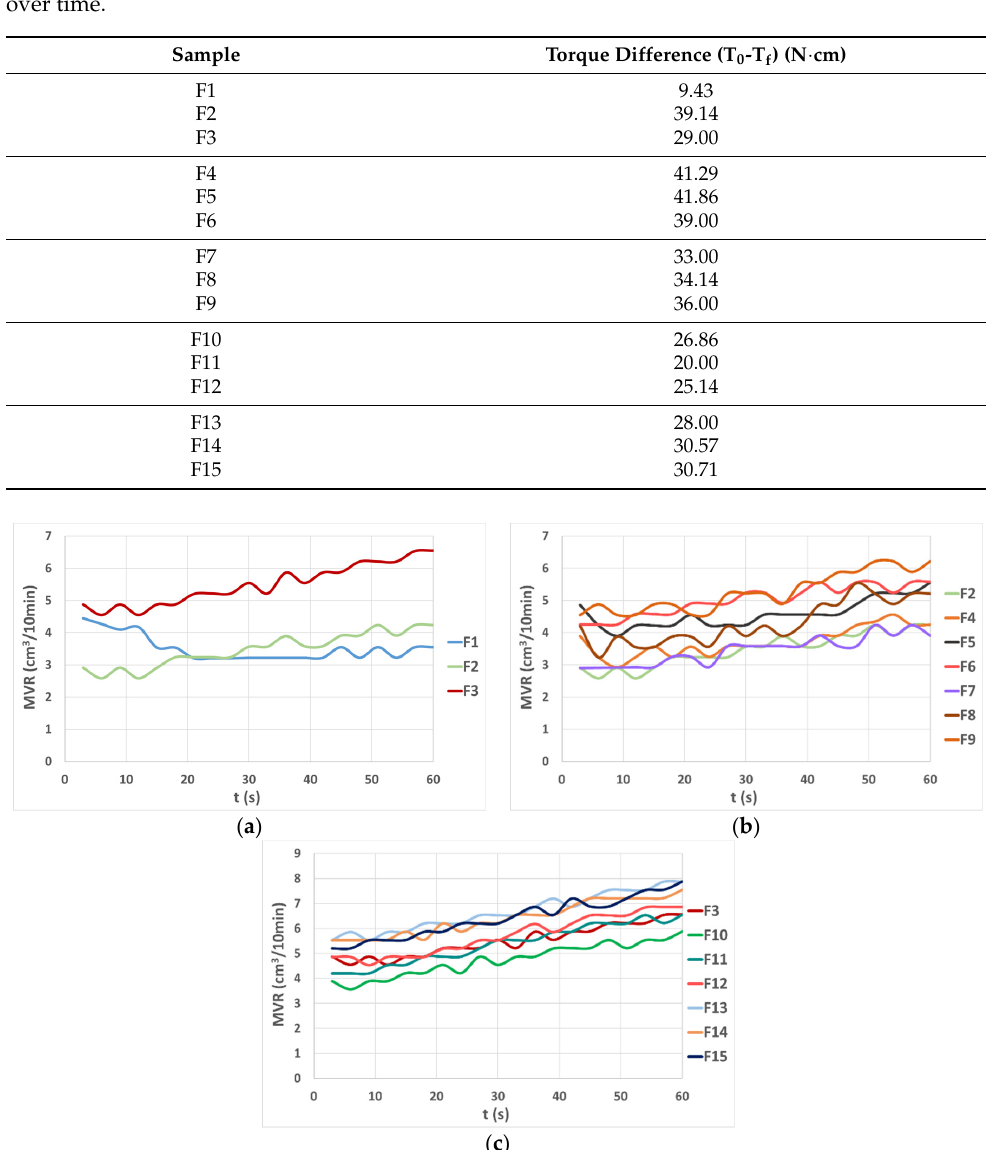
Figure 3. MVR values of: ( a ) pure matrix (F1) and untreated HSP (F2, F3); ( b ) pure H0210 (F2) and with different concentration of ESO+MA (F4, F5, F6) and ESO/SA (F7, F8, F9); ( c ) pure HM200 (F2) and with different concentration of ESO+MA (F10, F11, F12) and ESO/SA (F13, F14, F15).